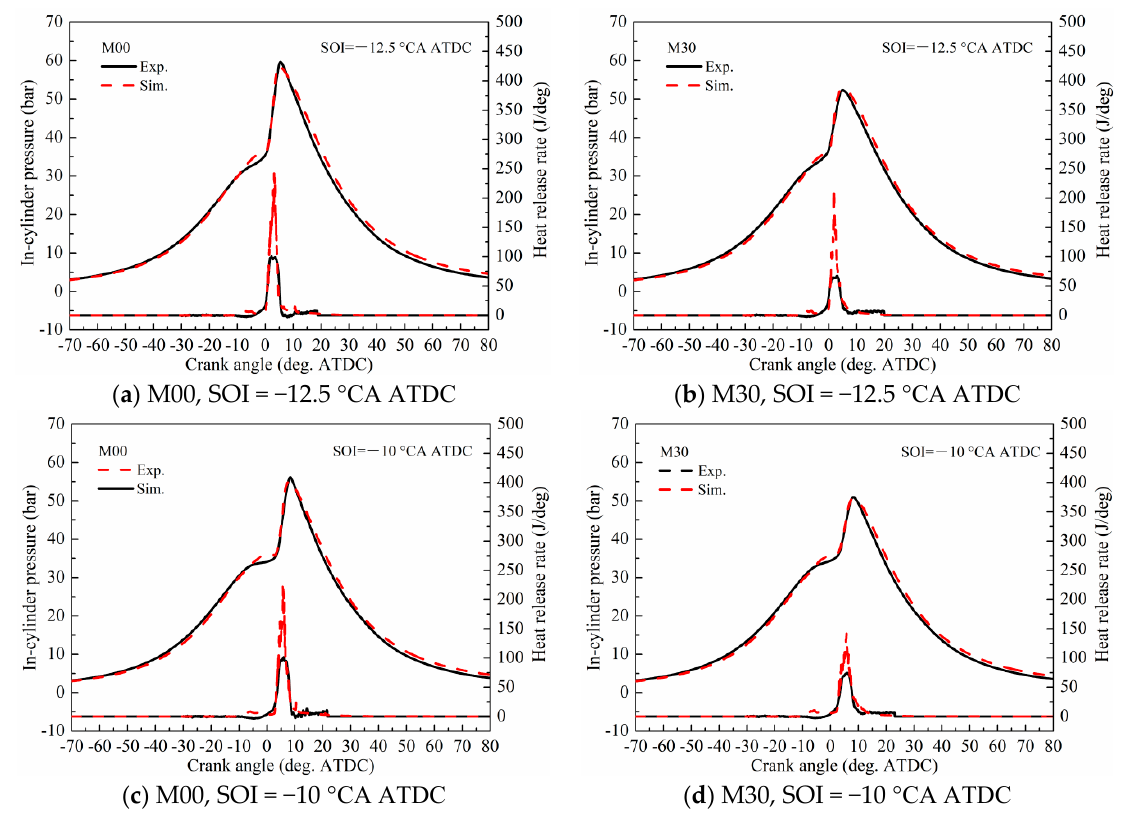
Figure 17. Comparisons between the modeled and experimental in-cylinder pressure and HRR profiles for M00 and M30.